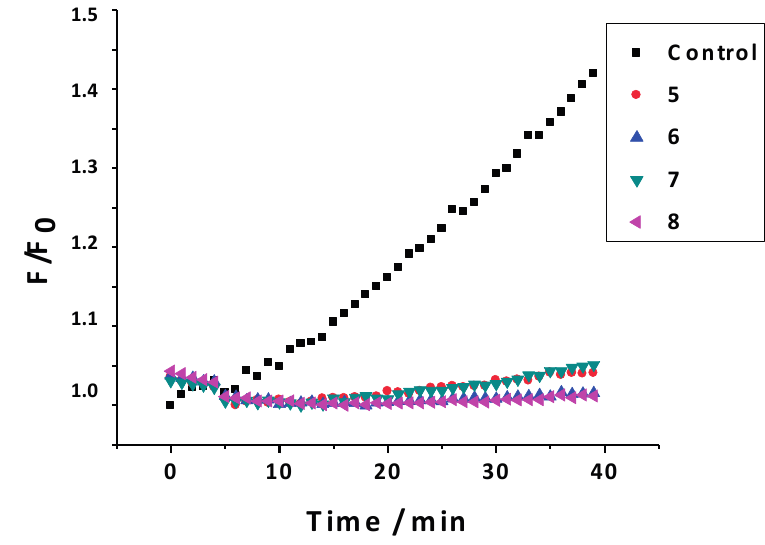
Figure 7. Graphic of ROS inhibition (control and compounds 5 – 8 at 10 μ M).